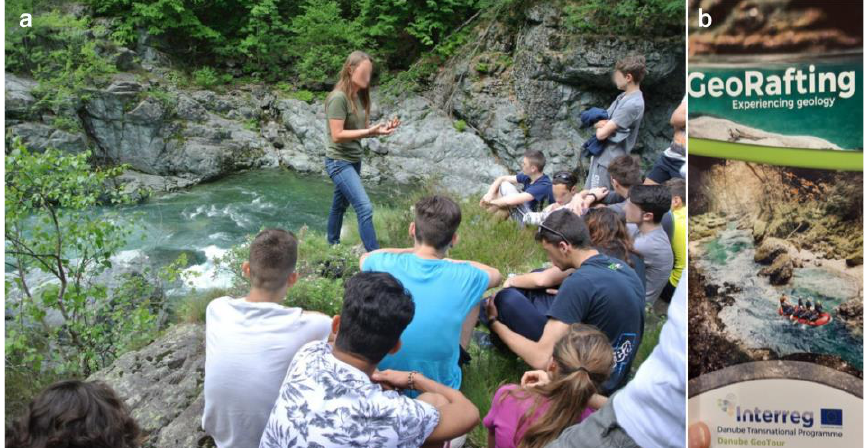
Figure 1. Georafting examples in UGGps: ( a ) preliminary attempts of georafting along the Sesia river in the Sesia Val Grande UGGp (photo courtesy of P. Arcostanzo, 2015); ( b ) leaflet of the georafting offer in the Steirische Eisenwurzen UGGp.